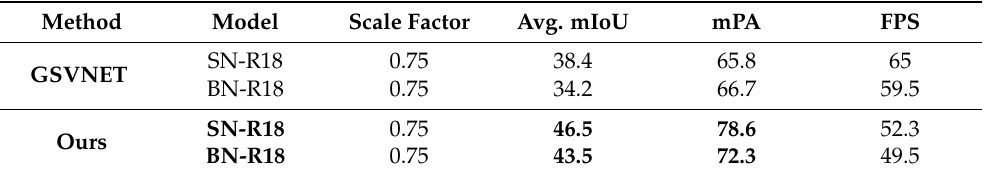
Table 1. The accuracy and throughput comparison using our dataset with GSVNET and our method. The scale factor specifies the downscale factor for key frames in the video sequences.